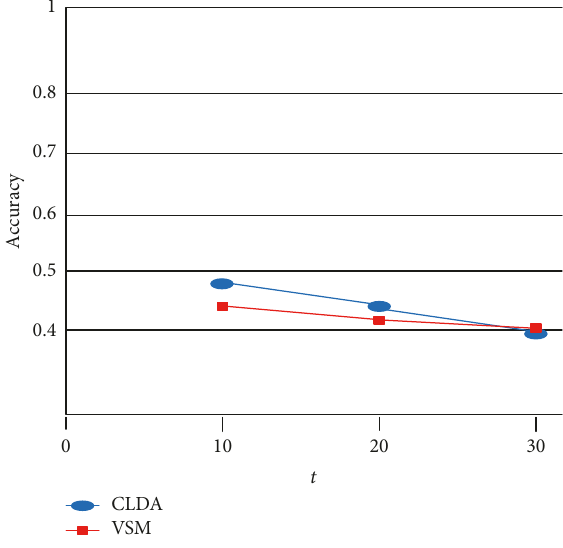
Figure 7: Recommended accuracy in medical